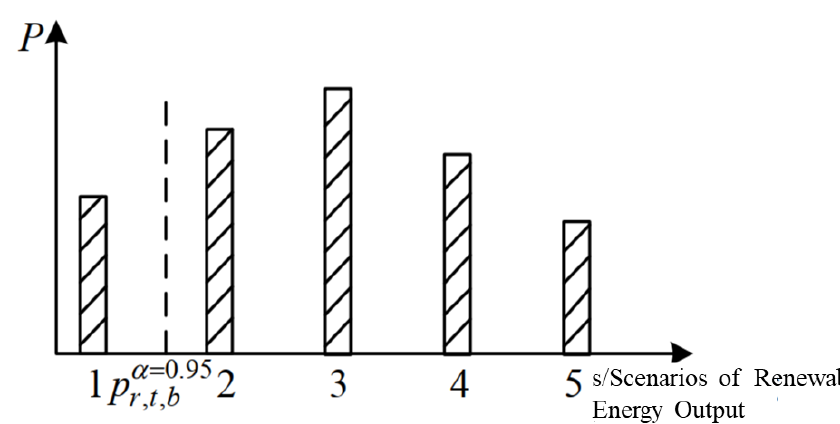
Figure 3. Renewable energy output discrete model.